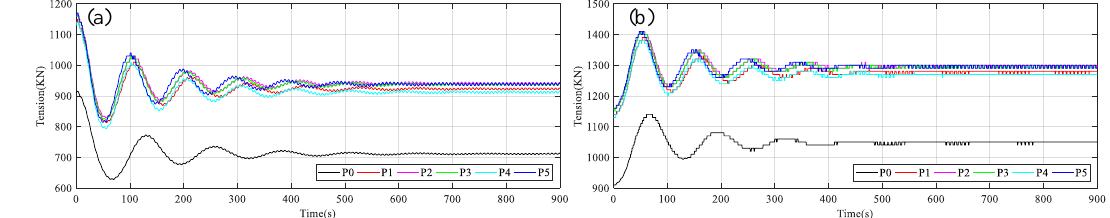
Figure 15. Fairlead tension in load case 2 for ( a ) fairlead 1, ( b ) fairlead 2.